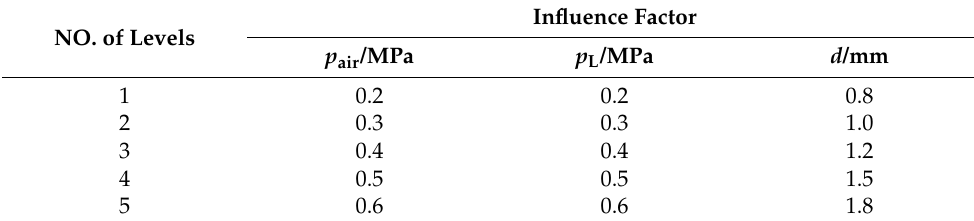
Table 1. Factors and levels in the orthogonal